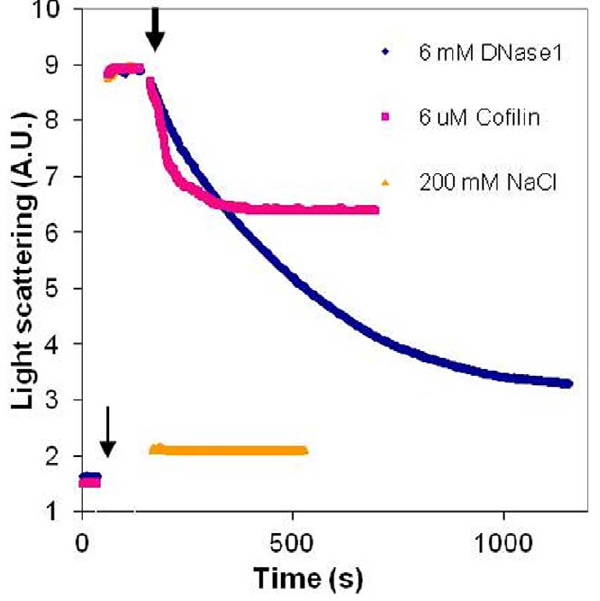
Figure 8. Kinetics of dissociation of MgF-actin bundles by DNase 1, cofilin and NaCl. LL-37 (9 m M) was added to 4 m M MgF- actin (thin arrow), inducing immediate bundling. This was followed by the addition of 6 m M DNase1, 6 m M cofilin, or 200 mM NaCl (thick arrow). Bundling and dissociation were followed as an increase and decrease in light scattering, respectively, measured at 450 nm. Presented data are representative of three independent experiments.